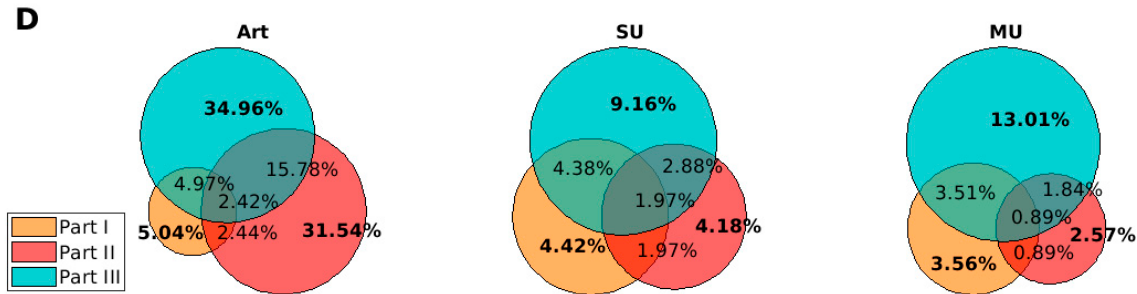
Figure 4. Performance of the DER algorithm applied to human single-unit recordings. ( A ) Exemplary raster plot of a recording before and after detection of artificial events using the DER algorithm. In the middle raster plot, all detected events are colored according to the part of the algorithm that detected them. ( B ) Raster plots of two units recorded from the same microwire bundle (right posterior hippocampus, RPH) that responded to two different stimuli (left: Stimulus 1—Helene Fischer; right: Stimulus 2—Otto Waalkes). The raster plots are plotted once with all extracted spike events (before DER—upper raster plots; spike events are marked according to the different parts of the DER algorithm using the same colors as in A ) and once after removal of the duplicate spike events (after DER—lower raster plots). On the left, the spike waveforms of both clusters are shown as density plots. The first unit (RPH 2) responded to the image of the German comedian Otto Waalkes (Stimulus 2). This response displays no notable changes after applying the DER algorithm. The second unit on channel RPH 4 increased its firing rate to stimulus 1 and 2 in the original data. However, after deleting all events detected by the DER algorithm, the increase in firing rate to stimulus 2 was eliminated (red framed raster plot). ( C ) Boxplot of detected spike events (percentage of all spikes) separated by unit class and by the part of the DER algorithm. Part II is subdivided into the detection within the same channel and the same bundle. The y -axis is limited to 35% for visualization. ( D ) Percentage of detected spike events per unit class, separated into the three parts of the DER algorithm. Bold numbers indicate the percentage of spikes found in each individual part. Non-bold numbers in the intersections show the percentage of spike events detected by several parts. For the purpose of visualization, intersecting areas are not to scale.